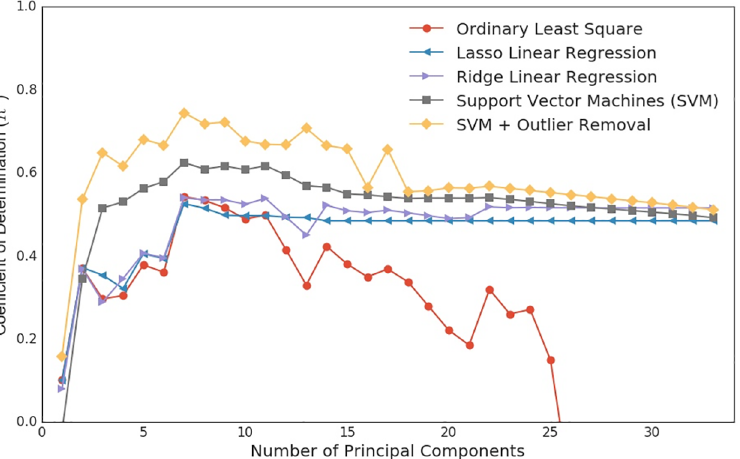
Fig 5. Comparison of performanceof proposed methodology using different regression methods. The proposedmethod can utilizes any regression method at its core and here its performance using four common regressionmethods on predicting GDP per capita basedon micro-socioeconomicindices is illustrated. The rightmost points can be interpretedas the values without using dimensionality reduction